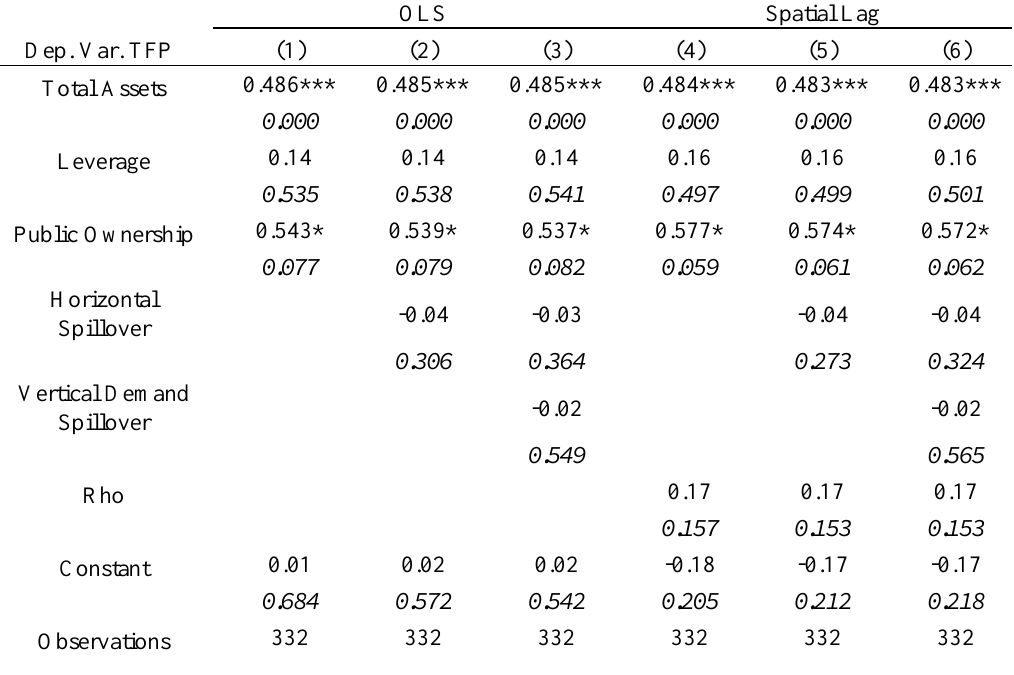
Table 3: Urban Domestic Productivity Determinants: The Electricity Generation